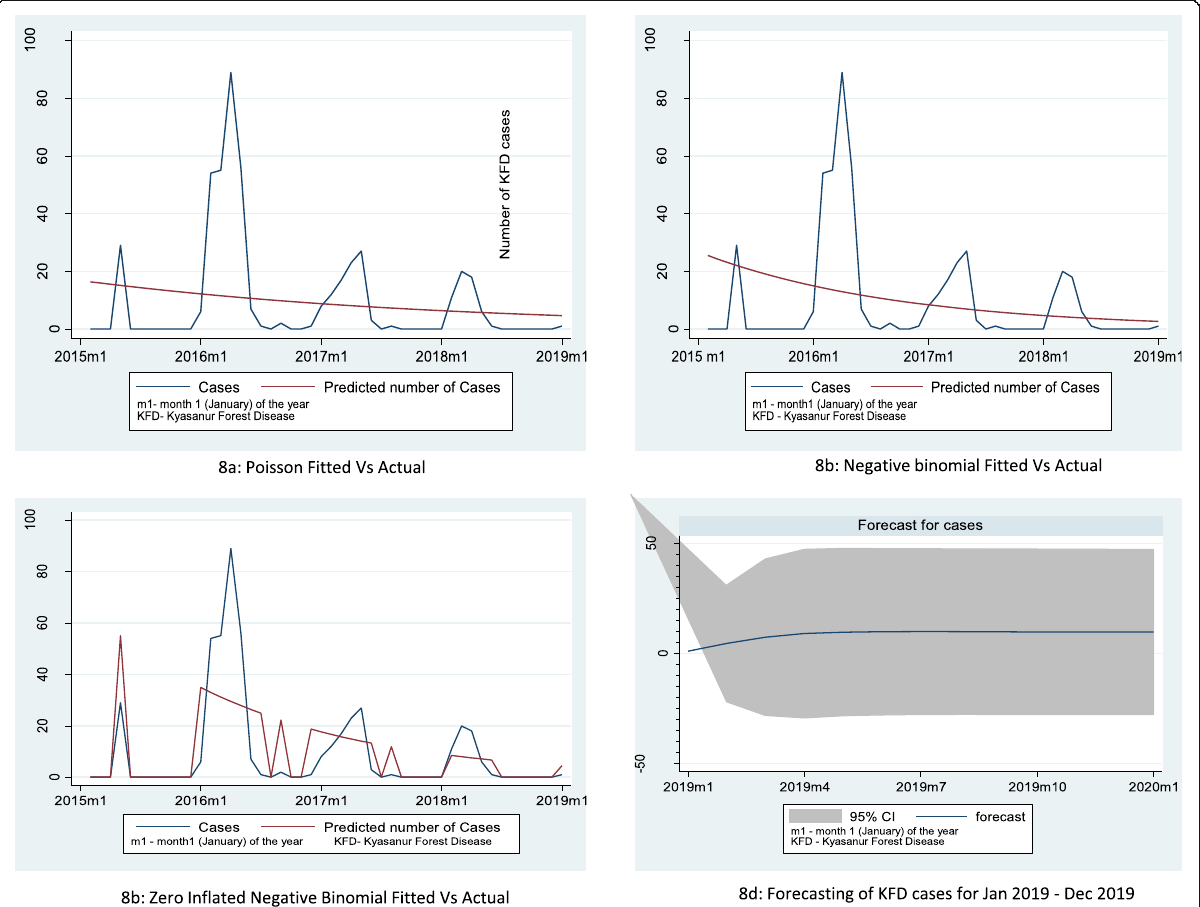
Fig. 8 Actual and fitted cases of Kyasanur Forest Disease in Goa, India, using various Poisson regression